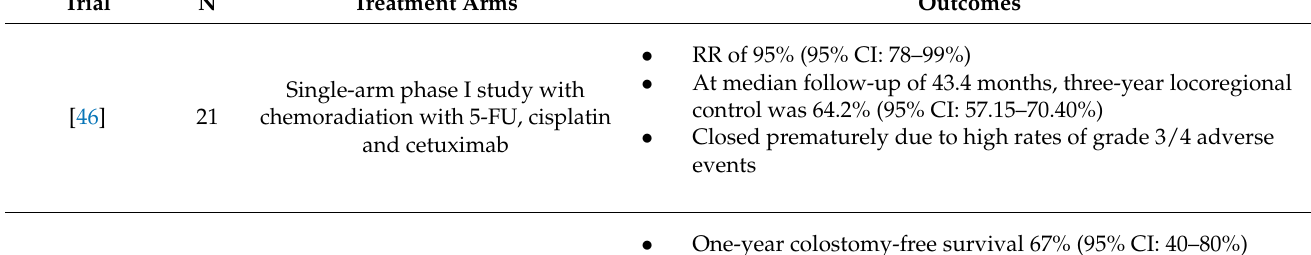
Table 3. Studies testing EGFR targeted therapy in